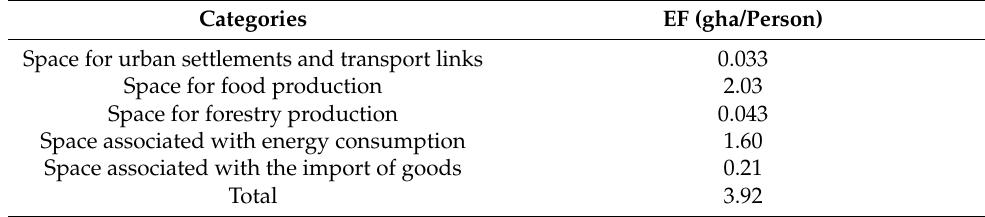
Table 10. Ecological footprint of Catalonia per capita in 2005.Source: Mayor et al., 2005. Categories EF (gha/Person) Space for urban settlements and transport links 0.033 Space for food production 2.03 Space for forestry production 0.043 Space associated with energy consumption 1.60 Space associated with the import of goods 0.21 Total